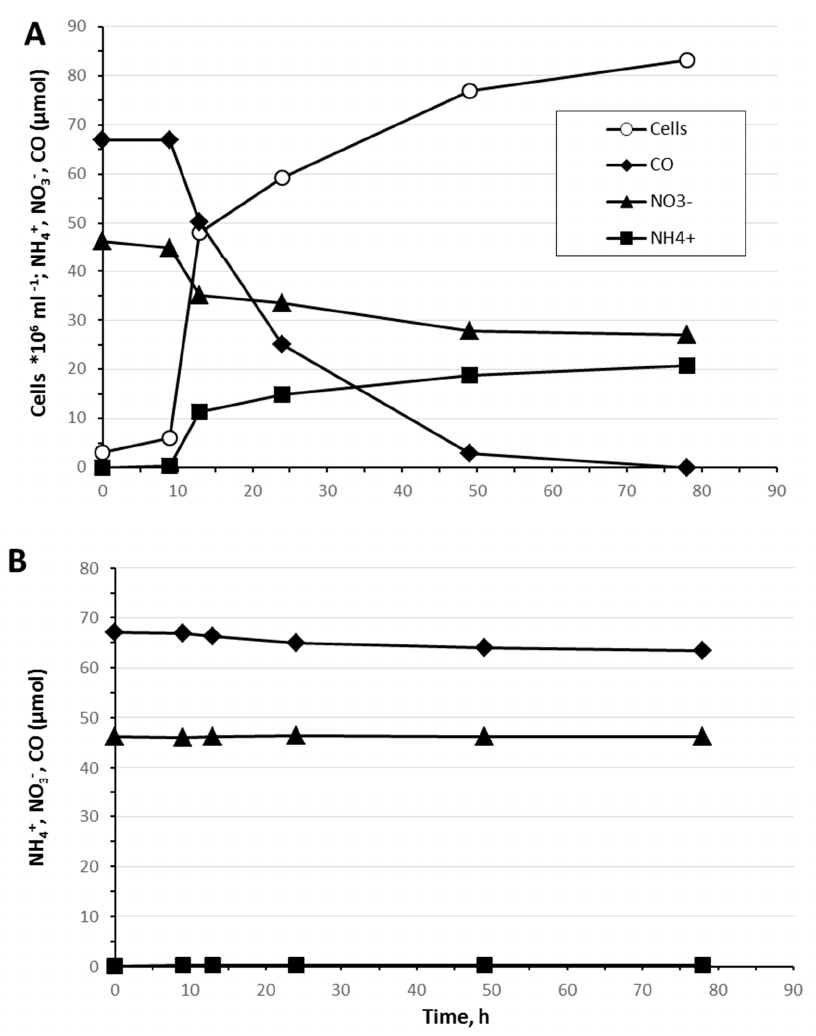
Figure 3. ( A ) Growth of D. autotrophicus with CO as an electron donor and nitrate as electron acceptor. ( B ) In non-inoculated controls, the concentration of CO and nitrate was not changed, and no ammonium accumulation was